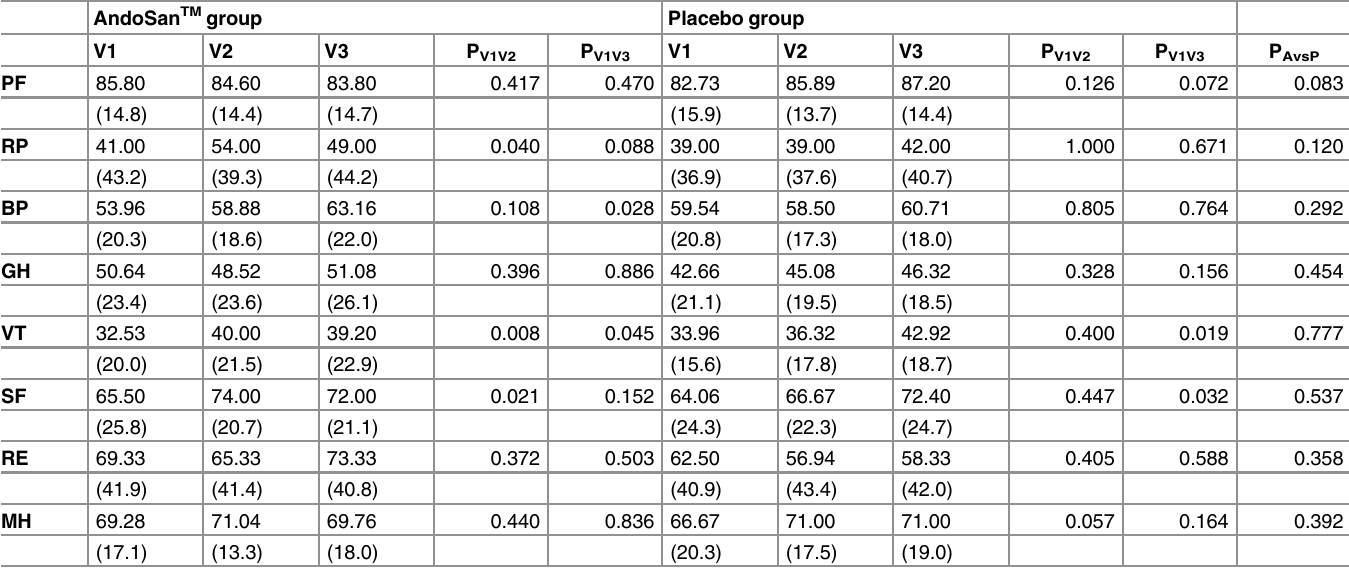
Table 6. Mean SF-36 scale scores (n = 25 AndoSan TM and n = 25 placebo) CD. AndoSan TM